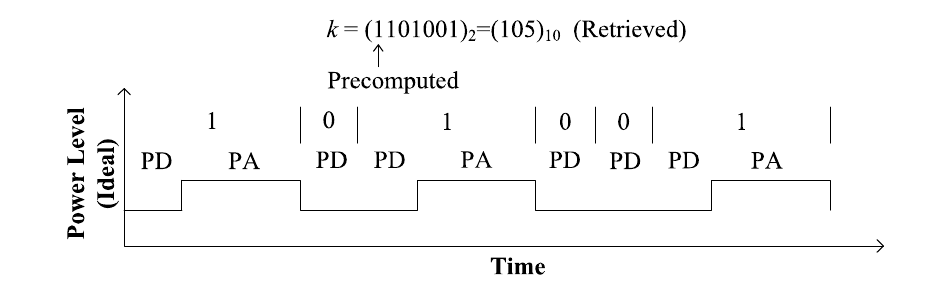
Figure 5. Simplistic representation of SPA in conventional DAA ECPM.